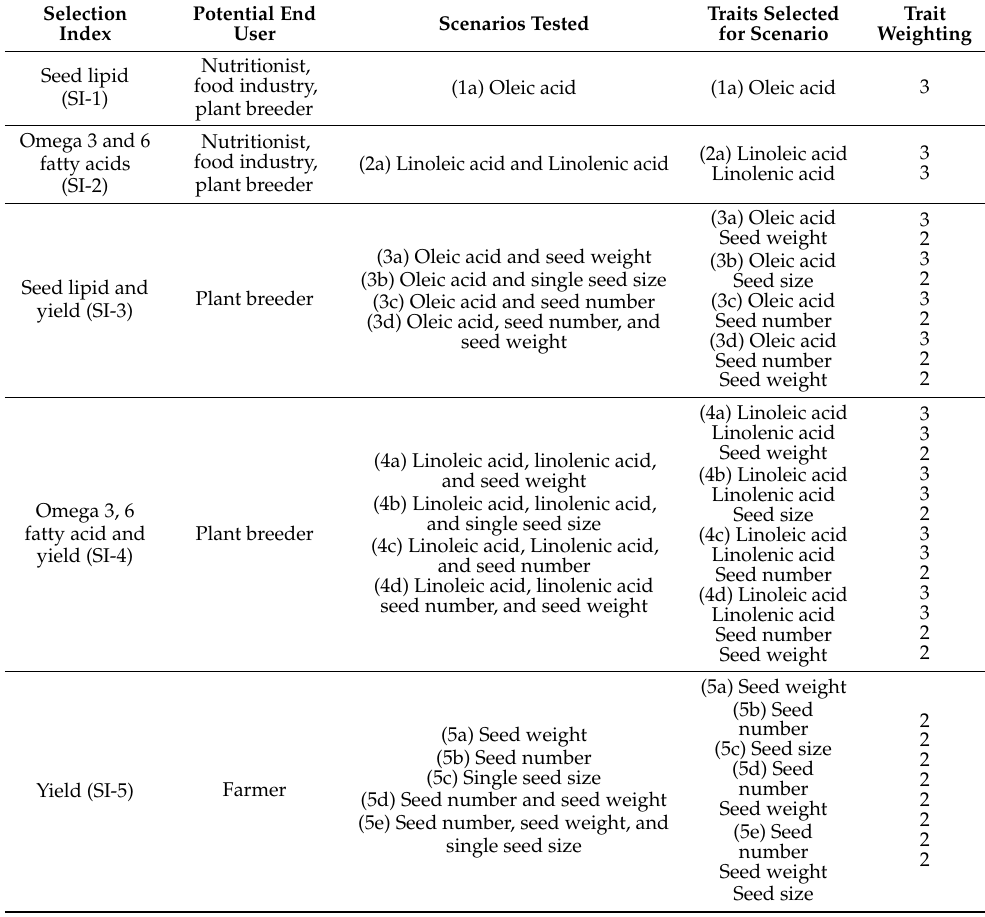
Table 4. Description of selection indices and the scenarios tested within each index in this study. Five indices and 15 scenarios were tested. Selection parameters (trait weightings and traits selected) for each scenario is indicated by corresponding SI number (1–5), and alphabets (a–e). For example, we tested four scenarios in SI3 using combinations of oleic acid and different yield traits and